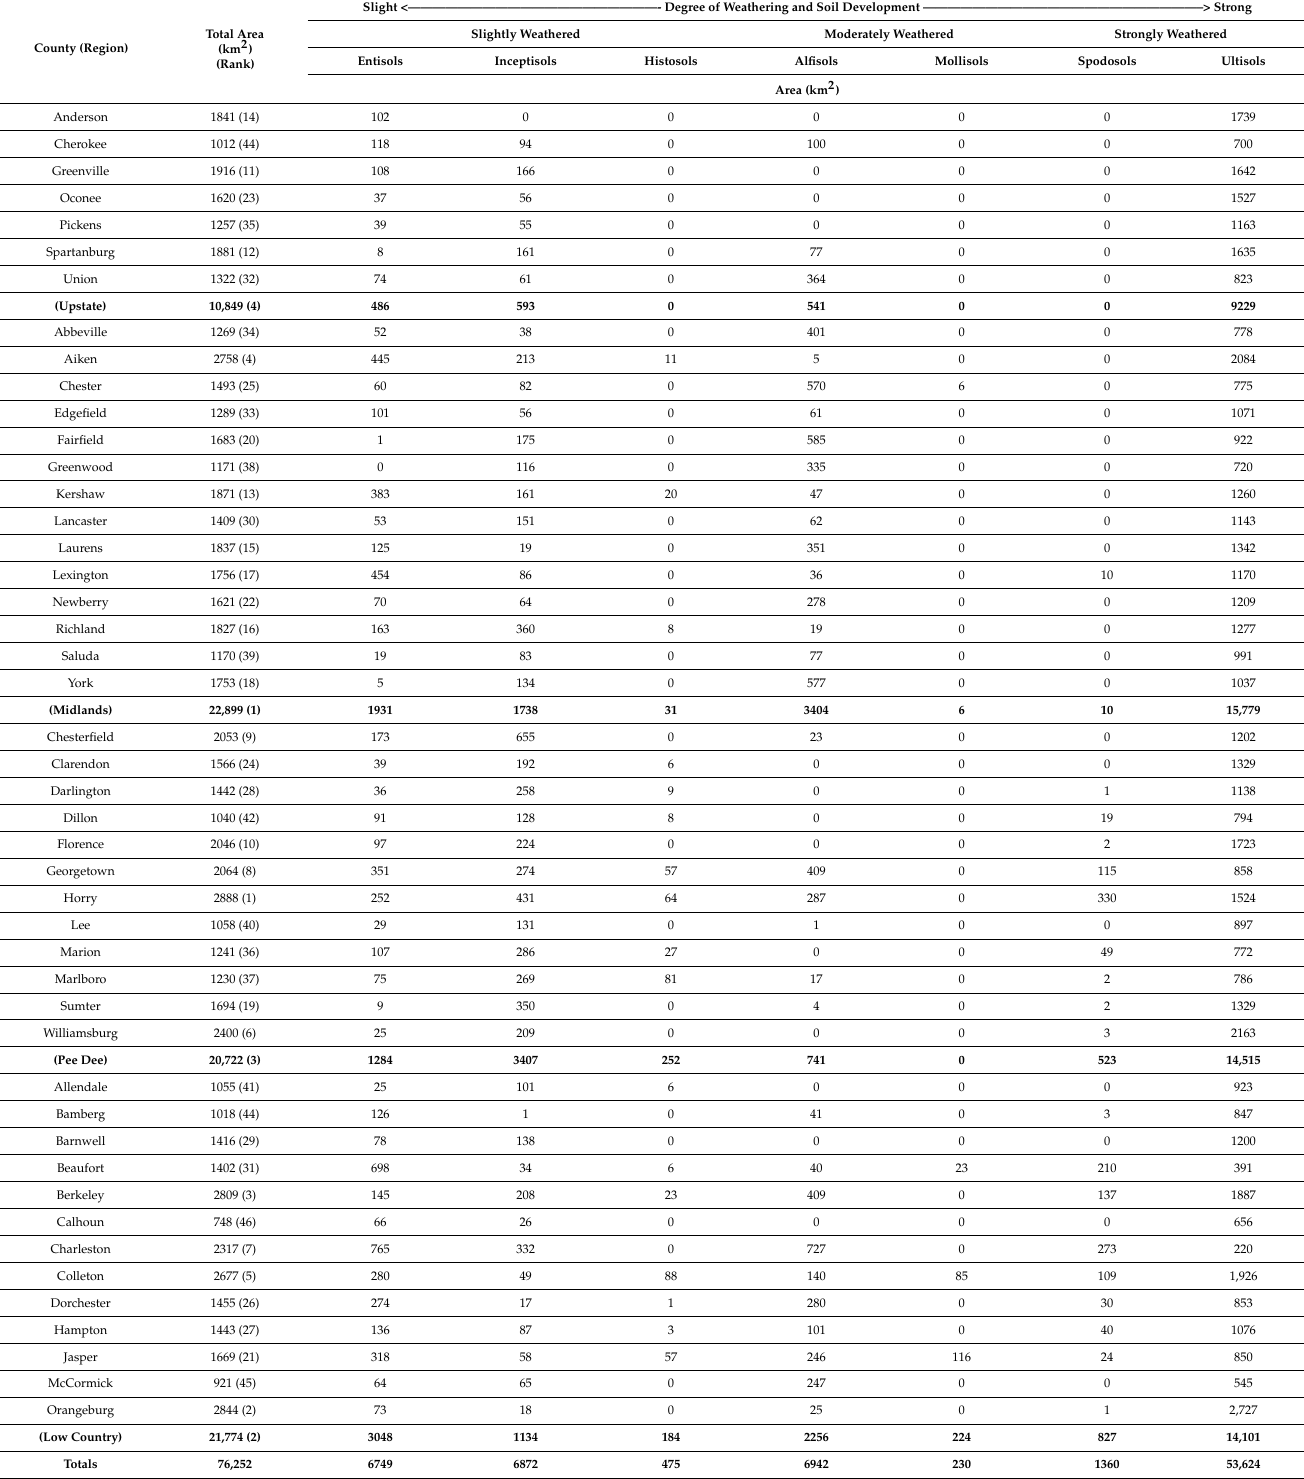
Table 3. Soil diversity (pedodiversity) by soil order (taxonomic pedodiversity), region, and county in South Carolina (U.S.A.) based on Soil Survey Geographic (SSURGO) Database (2020)